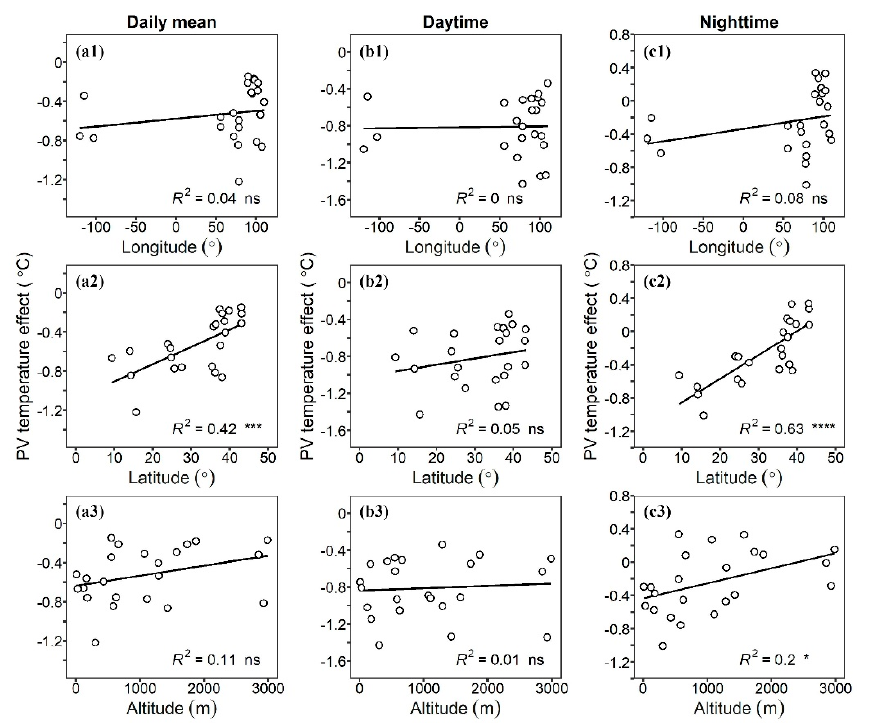
Figure 3. The relationship between annual ( a ) daily mean, ( b ) daytime and ( c ) nighttime PV temperature effect with ( a1,b1,c1 ) longitude, ( a2,b2,c2 ) latitude, and ( a3,b3,c3 ) altitude across the 23 PV powerplants. The solid lines are the linear regression lines; ns, *, **, *** and ****: statistically significant at p > 0.05, p < 0.05, p < 0.01, p < 0.001, and p < 0.0001 levels.